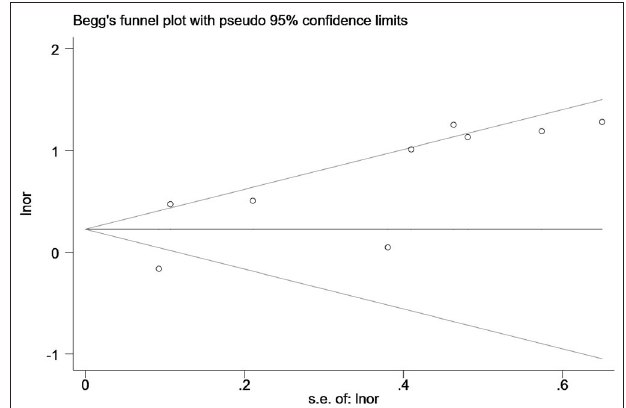
FIGURE 5 | Funnel plots without trim and fill.